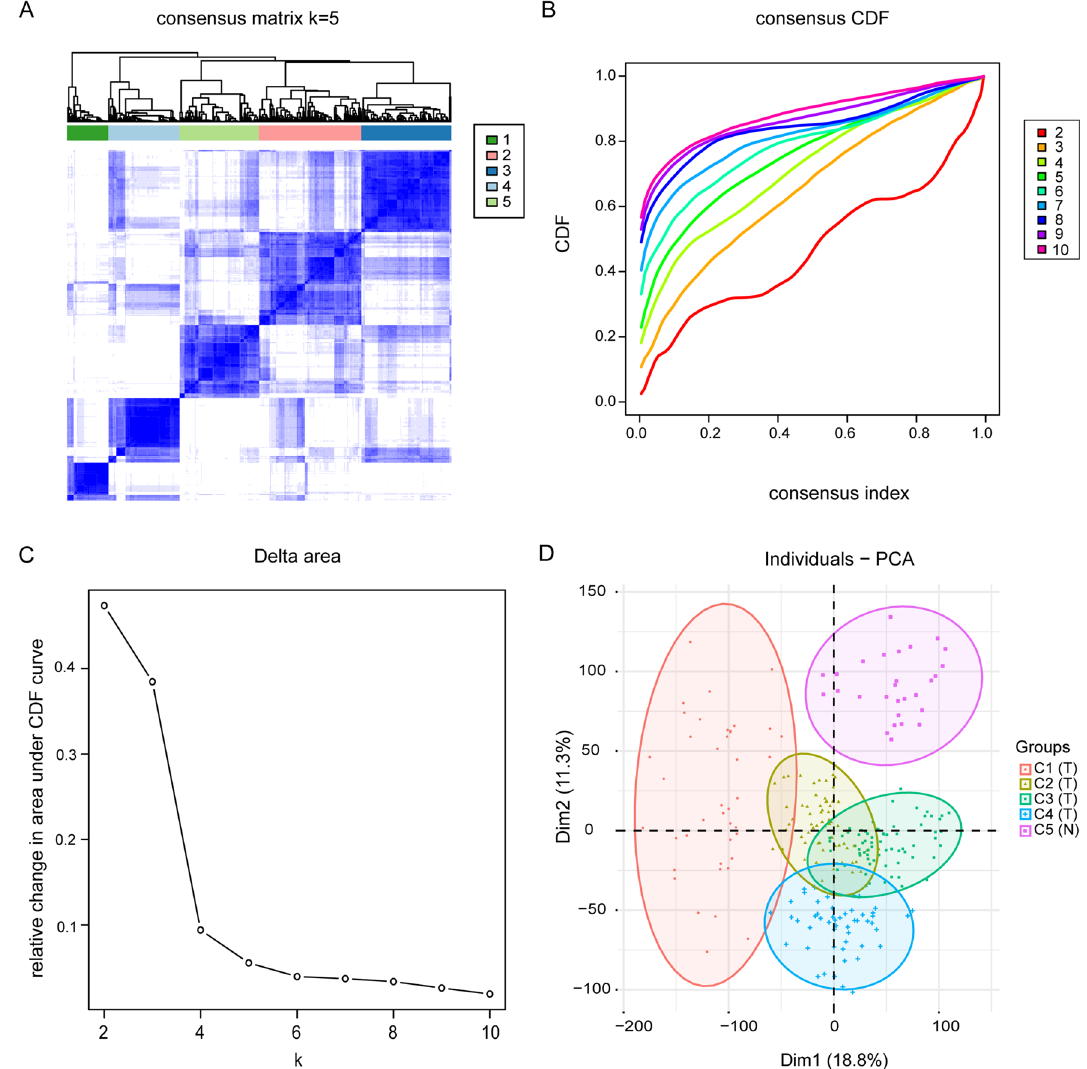
Figure 1. PCa tumor subtypes classification and identification in TCGA cohort. ( A ). The 550 samples were split into five clusters by the consensus clustering matrix (k = 5). ( B ).The consensus clustering approach established the cumulative distribution function (CDF) curve of Top 10. ( C ). The CDF Delta area curve of all samples with different k values. ( D ). Principal component analysis was carried out based on the results of consensus